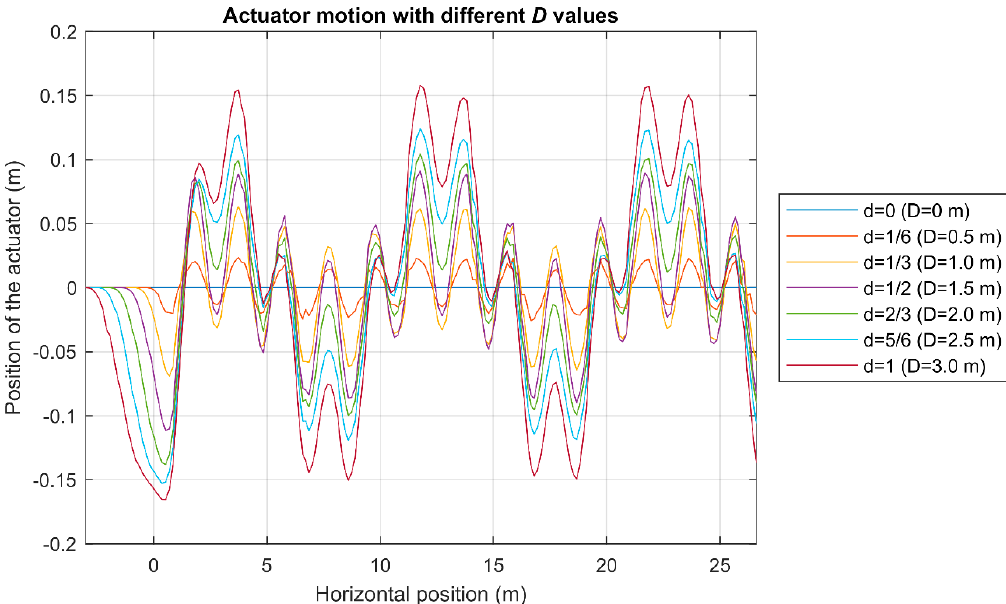
Figure 14. The motion of the actuator in the first ground profile.